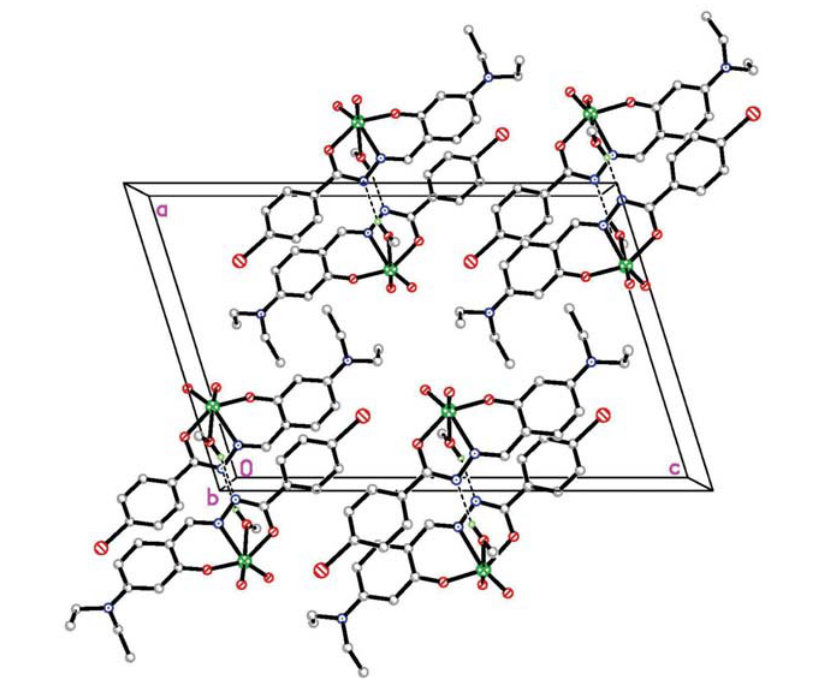
Figure 2. The hydrogen bonds linked dimeric structure of the